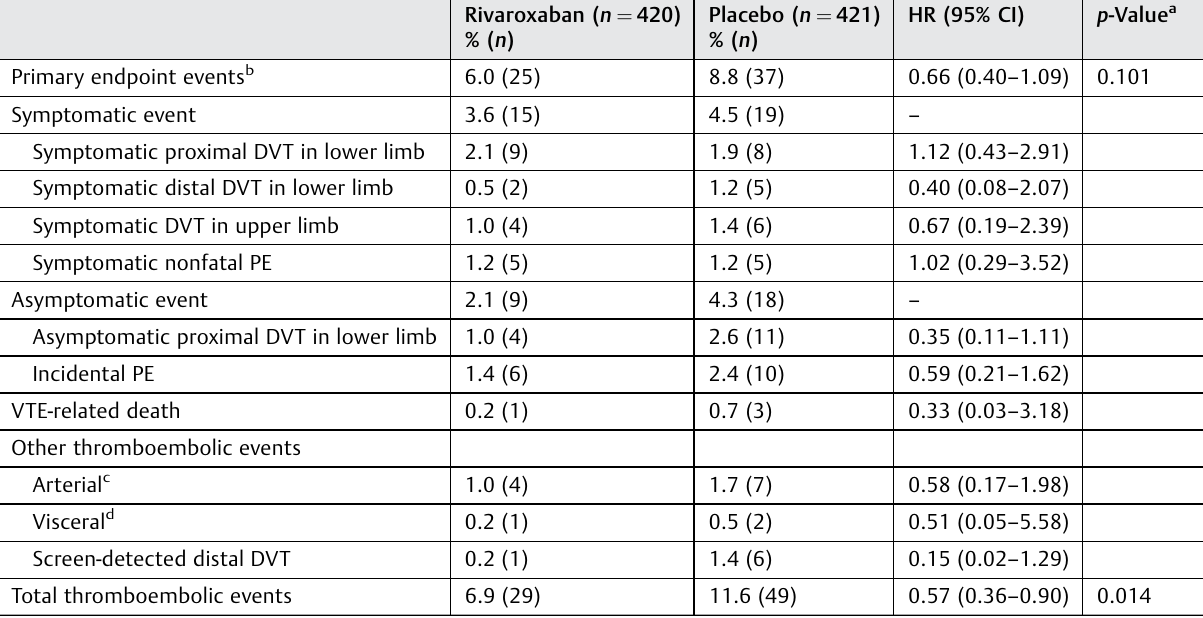
Table 1 Primary and secondary thromboembolic endpoint events during the full study period, according to study group